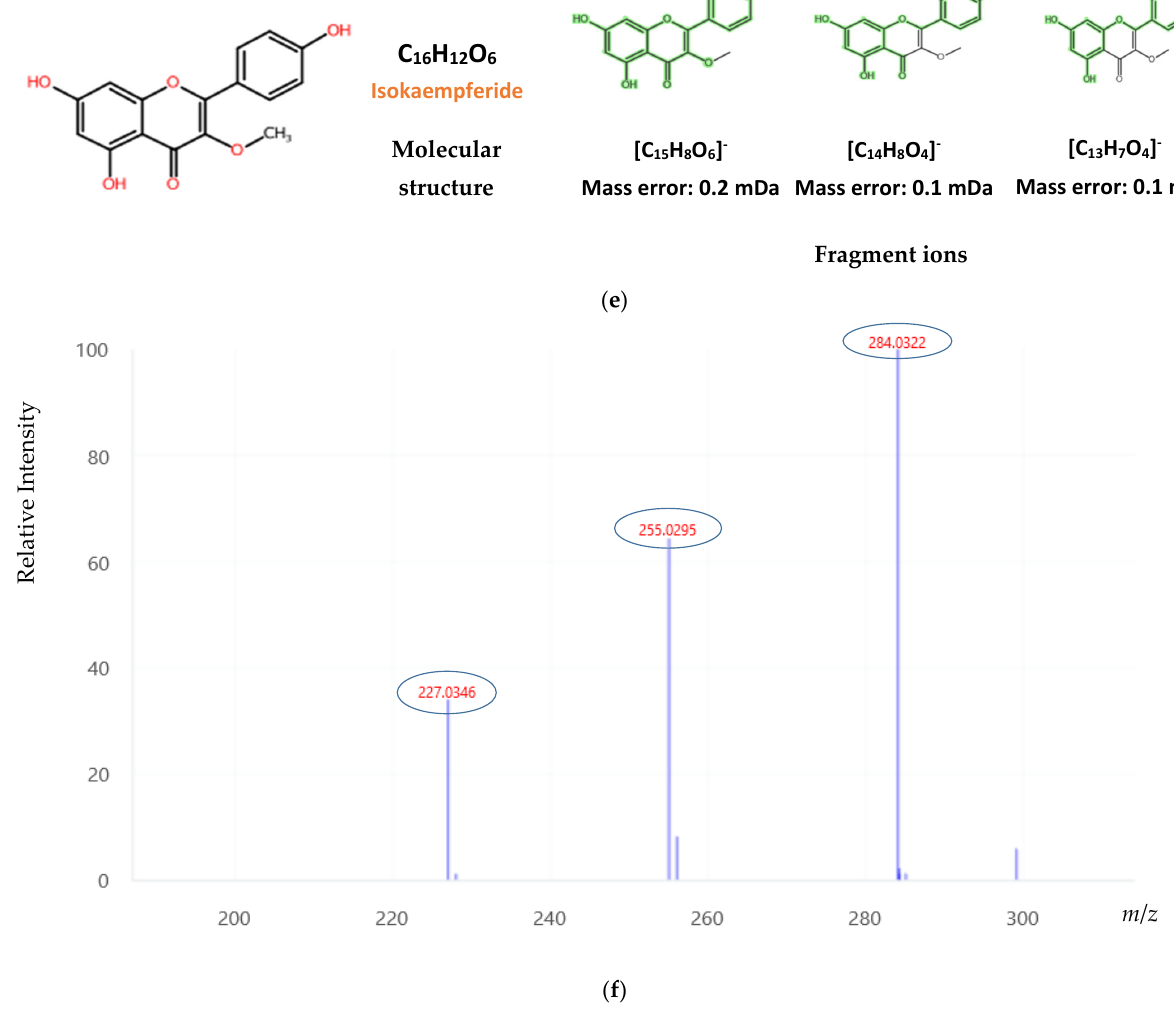
Figure 2. Identification data for the mass feature m / z 299.0561_8.44 min (Isokaempferide). ( a ) EIC of m / z 299.0561 in a blossom Honey; ( b ) Background subtracted MS Spectra from 8.3 to 8.6 min; ( c ) Molecular Formula Annotation of m / z 299.0561; ( d ) DDA MS/MS Spectra of 299.0561; ( e ) Structures of precursor and fragment ions (green part of the structure) of Isokaempferide; ( f ) Vaniya/Fiehn Natural Products Library Record VF ‐ NPL ‐ QTOF008090 (Isokaempferide).